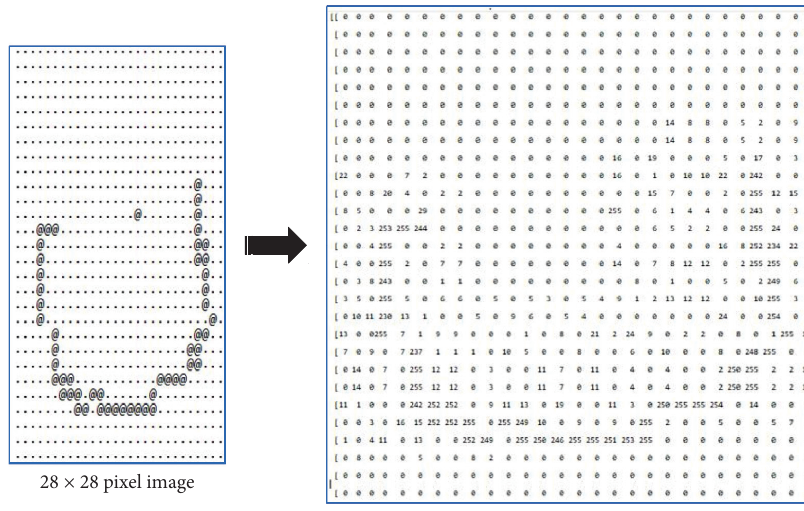
Figure 10: Image representation as 0–255 values.